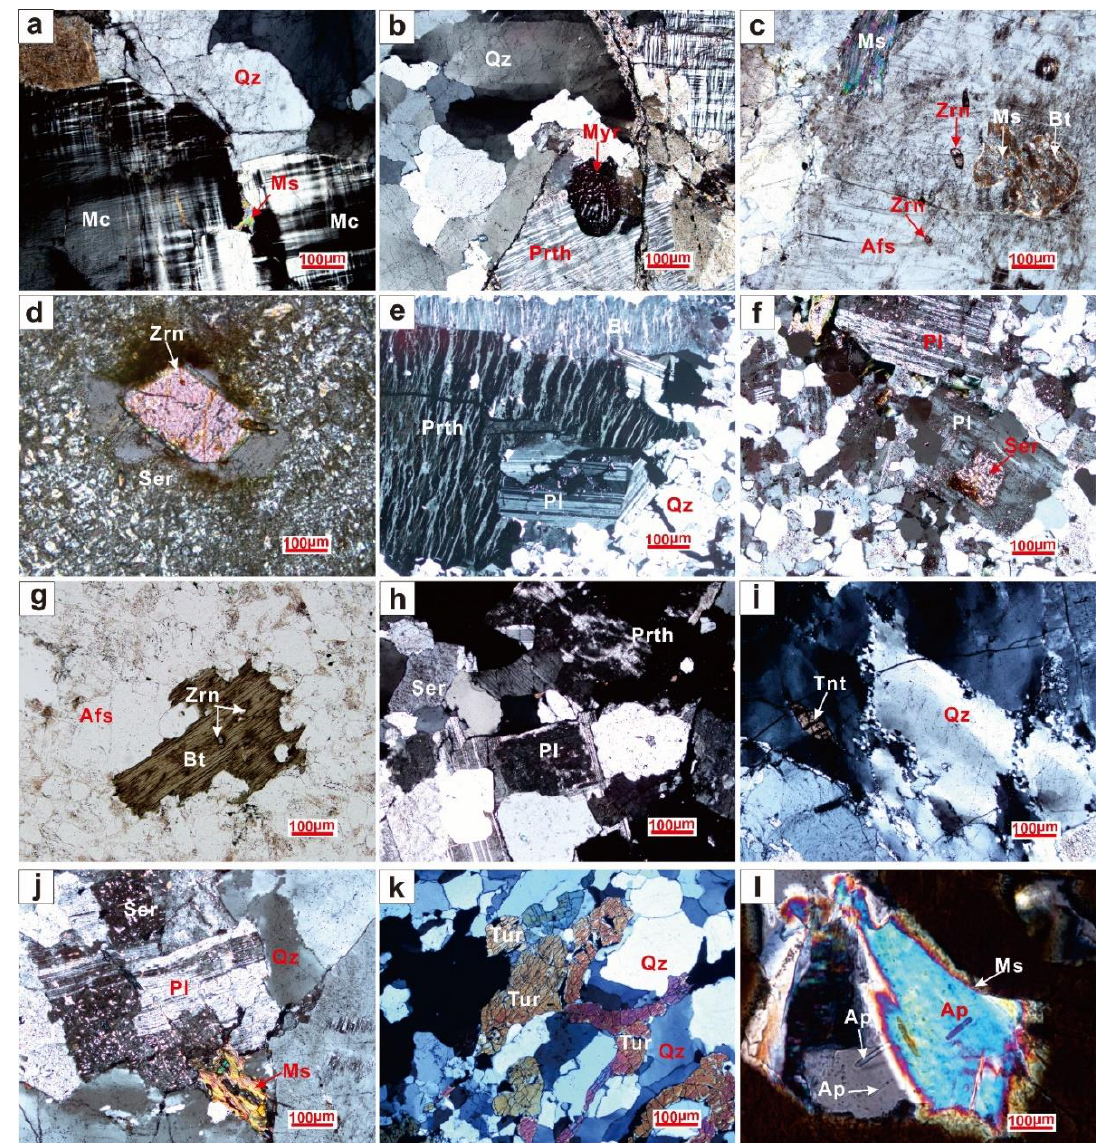
Figure 3. Photomicrographs of the studied samples (taken under cross-polarized light except for g, which is under plane-polarized light). ( a ) Beidao granite (TDG-1) showing a hypidiomorphic texture. ( b ) Sample from the Beidao granite (TDG-2) showing feldspars and quartz with obvious myrmekitic texture associated with perthite. ( c ) Beidao granite (TDG-3) showing alkali feldspar, biotite, secondary muscovite, and zircon. ( d ) Beidao granite (TDG-4) showing alkali feldspar altered into the sericite. The large zircon crystal contains melt inclusions. ( e ) Sample from the Caochuanpu granite (TCG-1) displaying phenocrysts of perthite, plagioclase, and quartz. ( f ) Sericite alteration in the core of zoned plagioclase (Caochuanpu granite, TCG-2). ( g ) Biotite grains exhibiting pleochroic haloes around zircons inclusions (Caochuanpu granite, TCG-3). ( h ) Yuanlongzhen granite displaying general textural features (TYG-1). ( i ) Yuanlongzhen granite (TYG-3) showing plagioclase, perthite, and quartz. Note some of the fine-grained recrystallized quartz have developed along the edges of the strained quartz. ( j ) Highly altered plagioclase pseudomorphs associated with biotite that contains tiny zircon inclusions (TYG-6). ( k ) Interstitial zoned tourmaline in the Roche type rock (RTR-1). ( l ) Muscovite with abundant fluorapatite inclusions (RTR-2). Abbreviations shown on the photomicrographs are: Afs: Alkali feldspar, Ap: fluorapatite, Bt: biotite, Mc: Microcline, Ms: muscovite, Myr: